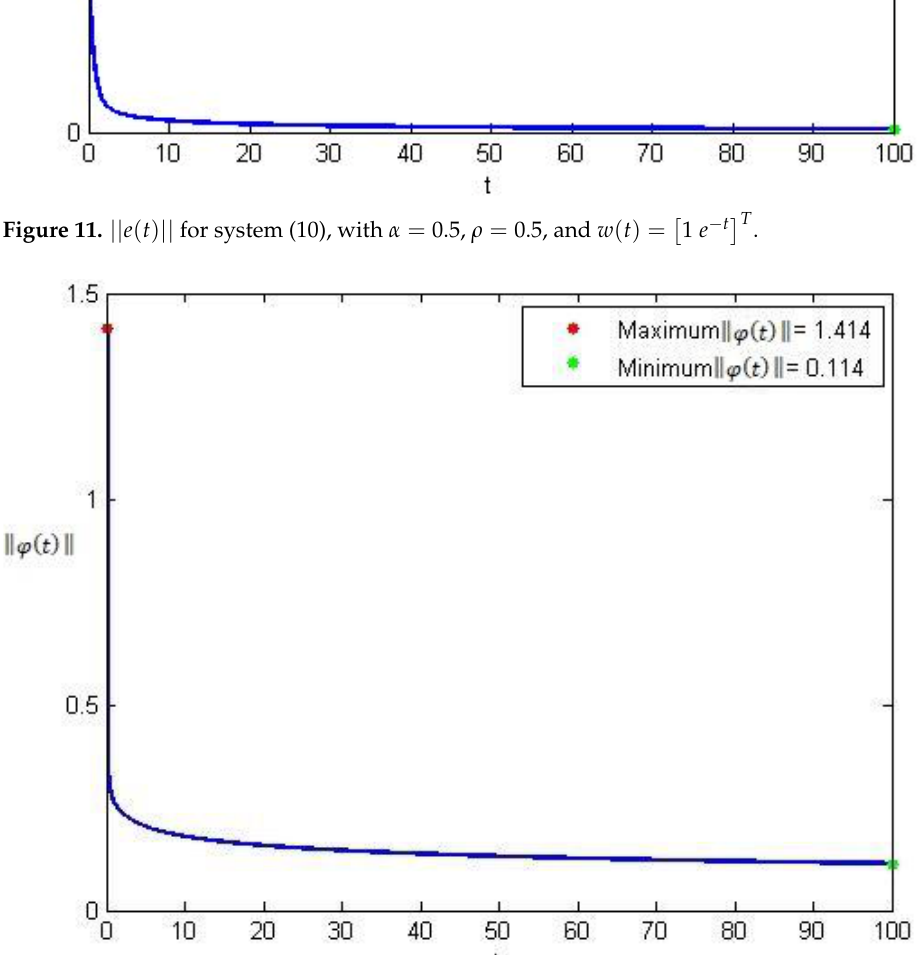
(cid:2) (cid:3) T 1 e − t